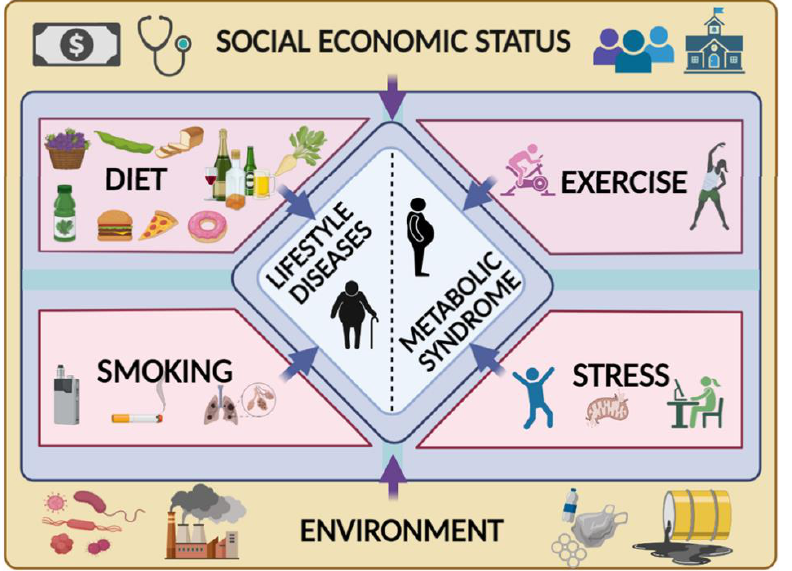
Figure 1. Diagrammatic representation of various modifiable risk factors that can affect the risk of lifestyle diseases. (Created with BioRender.com).